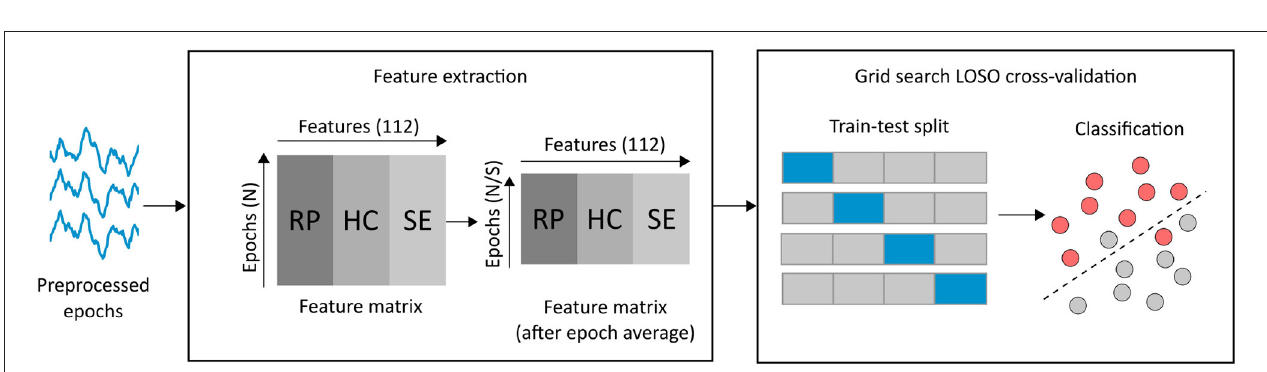
FIGURE 3 | EEG-based feature extraction and classification pipeline. First, we performed feature extraction on the 4-s clean epochs from all the participants. This yielded a feature matrix with 112 columns (features) and as many columns as the total number of epochs ( N ). Next, we averaged every S consecutive epochs to enhance the SNR of the features (we evaluated values of 6, 8, 10, and 12 for S). Then, we implemented a grid search cross-validation procedure to find the best hyperparameters for two possible classifiers (SVM and LR). We selected a LOSO strategy for cross-validation. Finally, we estimated the classification performance metrics across all the